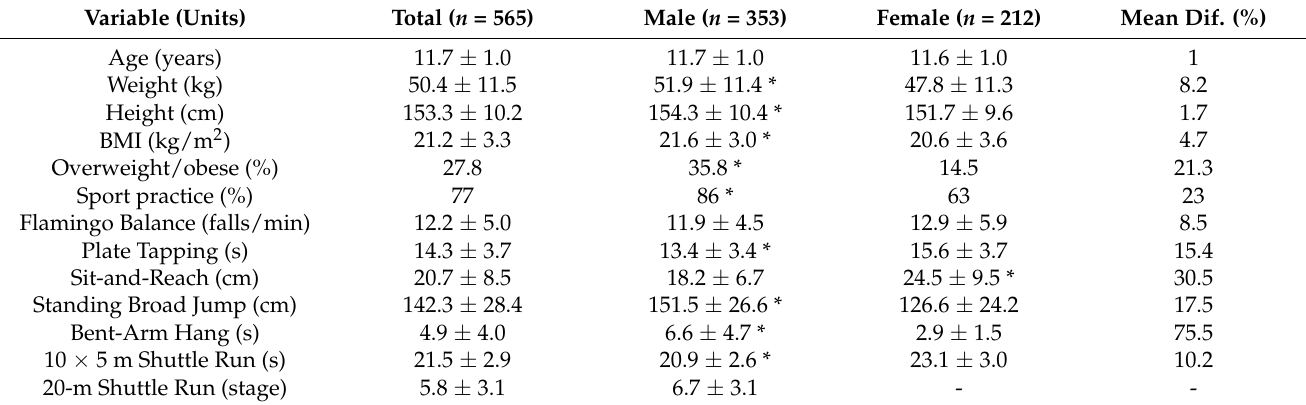
Table 1. Anthropometric, sport practice, and physical fitness characteristics of